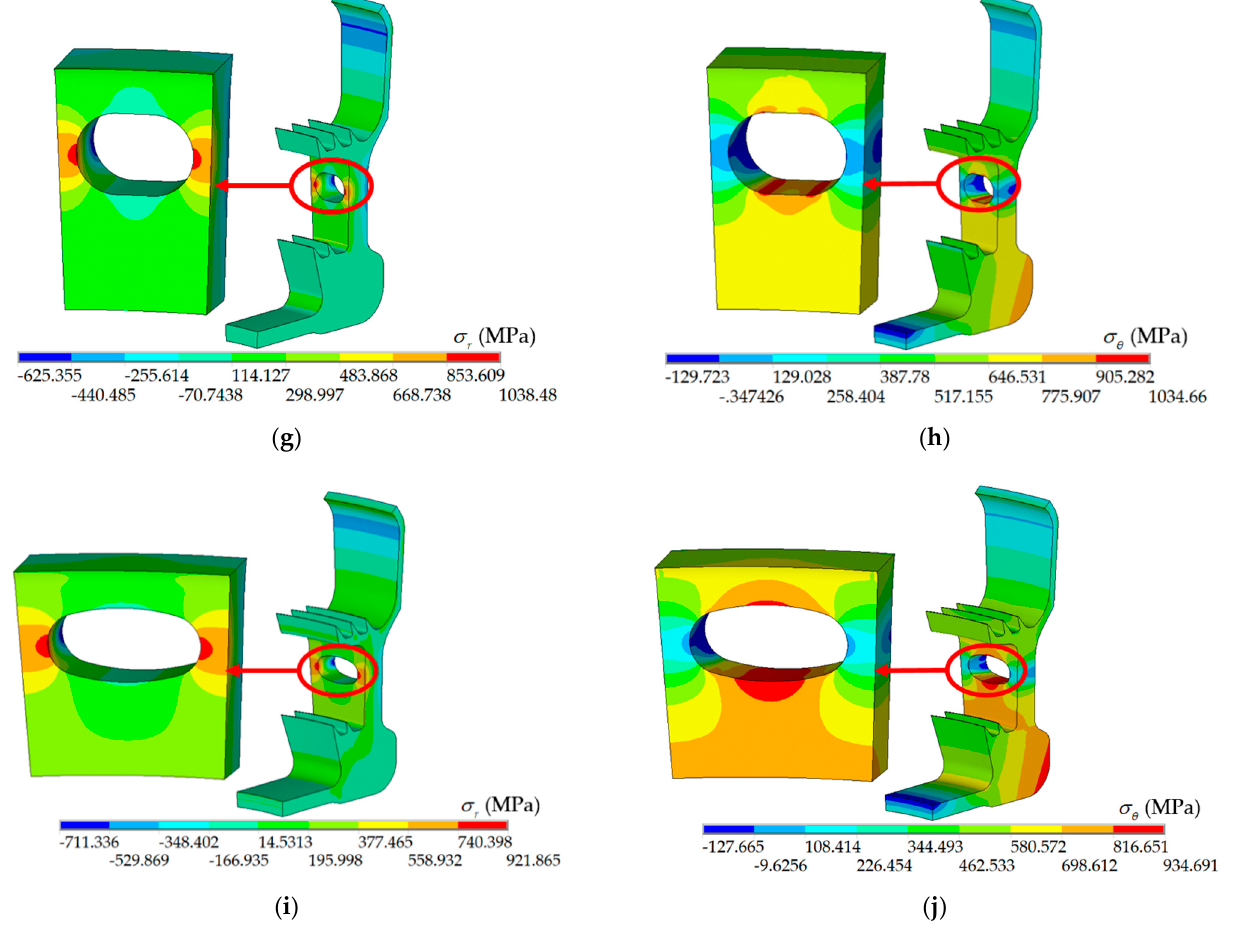
Figure 11. Radial and circumferential stress distribution of the initial circular and four optimal schemes. ( a ) Radial stress distribution of the initial circular scheme; ( b ) Circumferential stress distribution of the initial circular scheme; ( c ) Radial stress distribution of the optimal circular scheme; ( d ) Circumferential stress distribution of the optimal circular scheme; ( e ) Radial stress distribution of the optimal elliptical scheme; ( f ) Circumferential stress distribution of the optimal elliptical scheme; ( g ) Radial stress distribution of the optimal race-track scheme; ( h ) Circumferential stress distribution of the optimal race-track scheme; ( i ) Radial stress distribution of the optimal four-arc scheme; and ( j ) Circumferential stress distribution of the optimal race-track scheme.